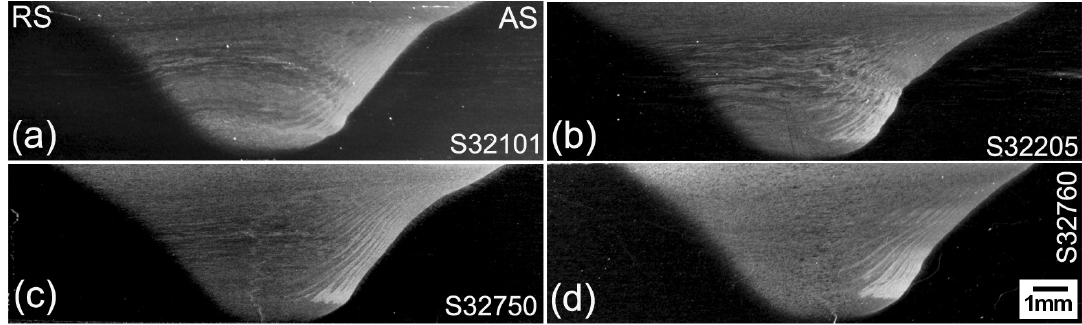
Fig. 4. Cross sections of DSS FSW joints: (a) UNS S32101, (b) S32205, (c) S32750, and (d) S32760.